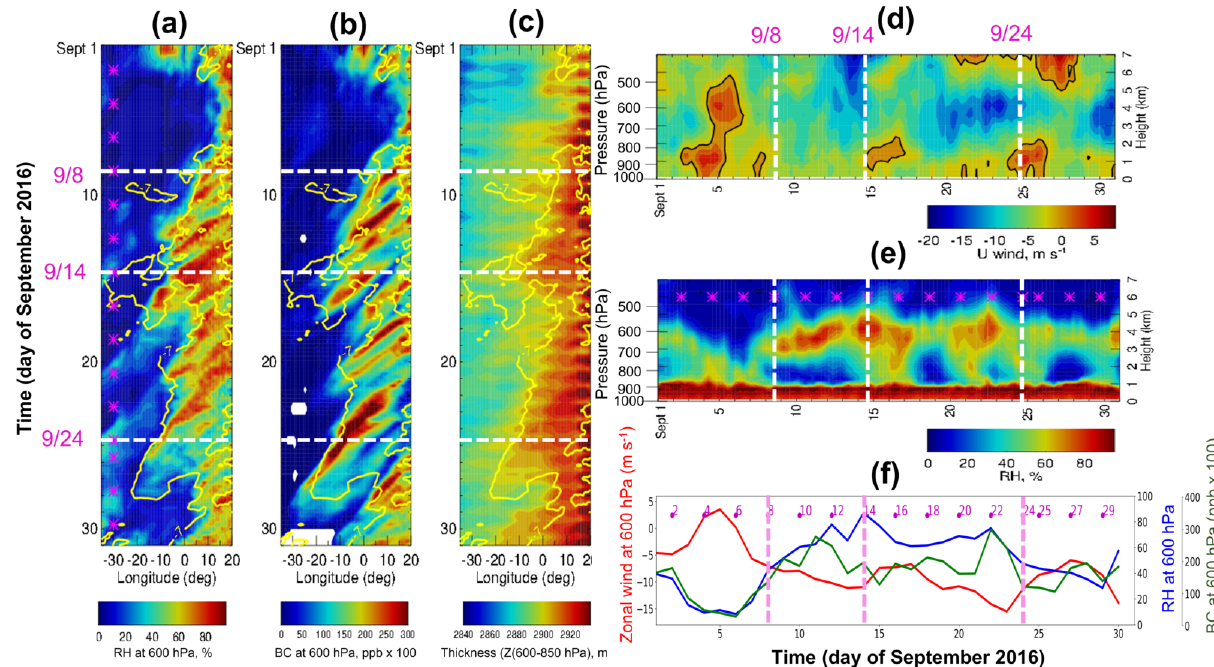
Figure 2. Longitude–time cross section of every 6h of (a) 600hPa RH (%), (b) 600hPa BC (shading; ppb × 100), and (c) thickness (geopo- tential height difference of 600–850hPa); high values ( > 2920m) over a southern African plateau represents the heat low; m) averaged over 8–10 ◦ S during September 2016. Panels (a) – (c) are overlaid by 600hPa zonal wind isotach (yellow line; − 7ms − 1 ). (d, e) Altitude–time cross section of zonal wind and RH at 10 ◦ S, averaged over 0–10 ◦ E during September 2016. The black contour in panel (d) represents the zero value of zonal wind. (f) Daily time series of the 600hPa zonal wind (red line; ms − 1 ), 600hPa RH (blue line; %), and 600hPa BC (green line; ppb × 100) averaged over 8–10 ◦ S and 0–10 ◦ E. The dashed white lines indicate the flight days investigated further in this study, and the magenta asterisks (and numbers in panel f ) represent the flight days during the September 2016 deployment. White areas in panel (b) represent the missing data